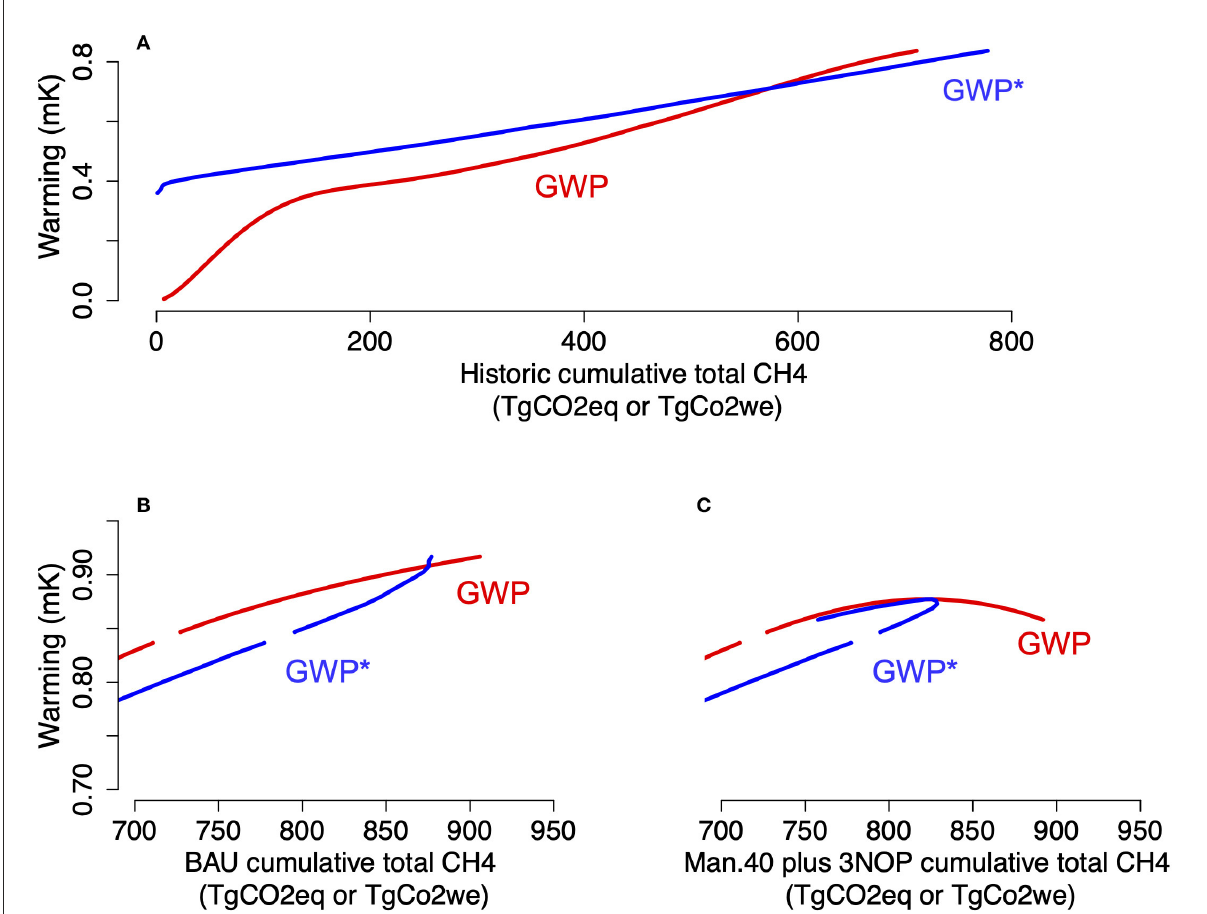
FIGURE6 The relationship of CO 2 eq and CO 2 we with modeled warming response to these emissions. The x -axis shows cumulative CO 2 eq calculated using GWP in red (“GWP”), or CO 2 we calculated using GWP* in blue (“GWP*”). The y axis shows warming from annual CH 4 . (A) Shows data from the historical (1950–2017) period. The slope of the line of cumulative CO 2 emissions and temperature change is approximately TCRE. (B) Shows future (2018–2029) BAU emissions, while (C) shows future (2018–2030) “Manure 40 plus 3NOP” reduction scenario emissions. Lines are broken between historical and future